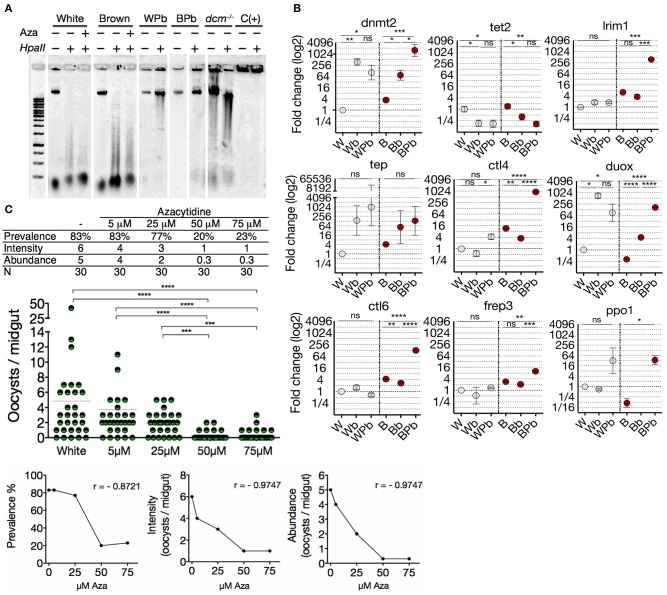
White and Brown phenotypes respond differently to a Plasmodium challenge in terms of DNA methylation and transcription of immune genes. (A) Midgut gDNA digestion with HpaII after Plasmodium infection or azacytidine treatment. Escherichia coli BL21 dcm−/− as a hypomethylated control, hypermethylated DNA as positive control C(+), White mosquitoes challenged with ookinetes (WPb), Brown mosquitoes challenged with ookinetes (BPb). (B) Transcriptional response of immune genes in White and Brown mosquitoes after an uninfected blood meal (mock culture; Wb and Bb, respectively) or Plasmodium berghei-infected blood meal (WPb and BPb, respectively) determined by qPCR and relative to White mosquito's expression. Mean ± SEM of three independent experiments, analyzed by ANOVA and Tukey post-hoc test. (C) Effect of different concentrations of azacytidine on the infection of the White-susceptible phenotype and correlation between the concentration of azacytidine treatment and infection prevalence, intensity, and abundance. Data was analyzed by Kruskal-Wallis and Dunn's multiple comparisons test. (r) Spearman correlation p < 0.0001. Asterisks represent the P values as follows: *P < 0.05, **P < 0.01, ***P < 0.001, ****P < 0.0001.